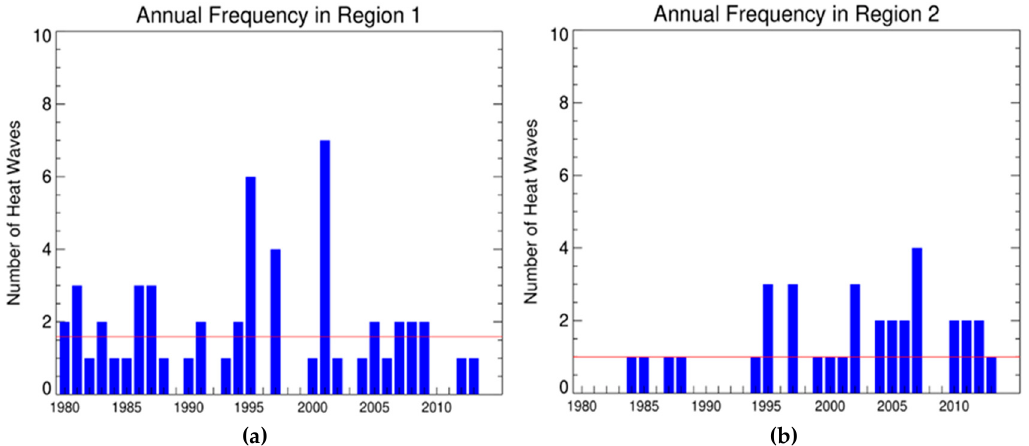
Figure 5. Number of heat waves per month from 1980 to 2013 in regions ( a ) 1 and ( b ) 2.